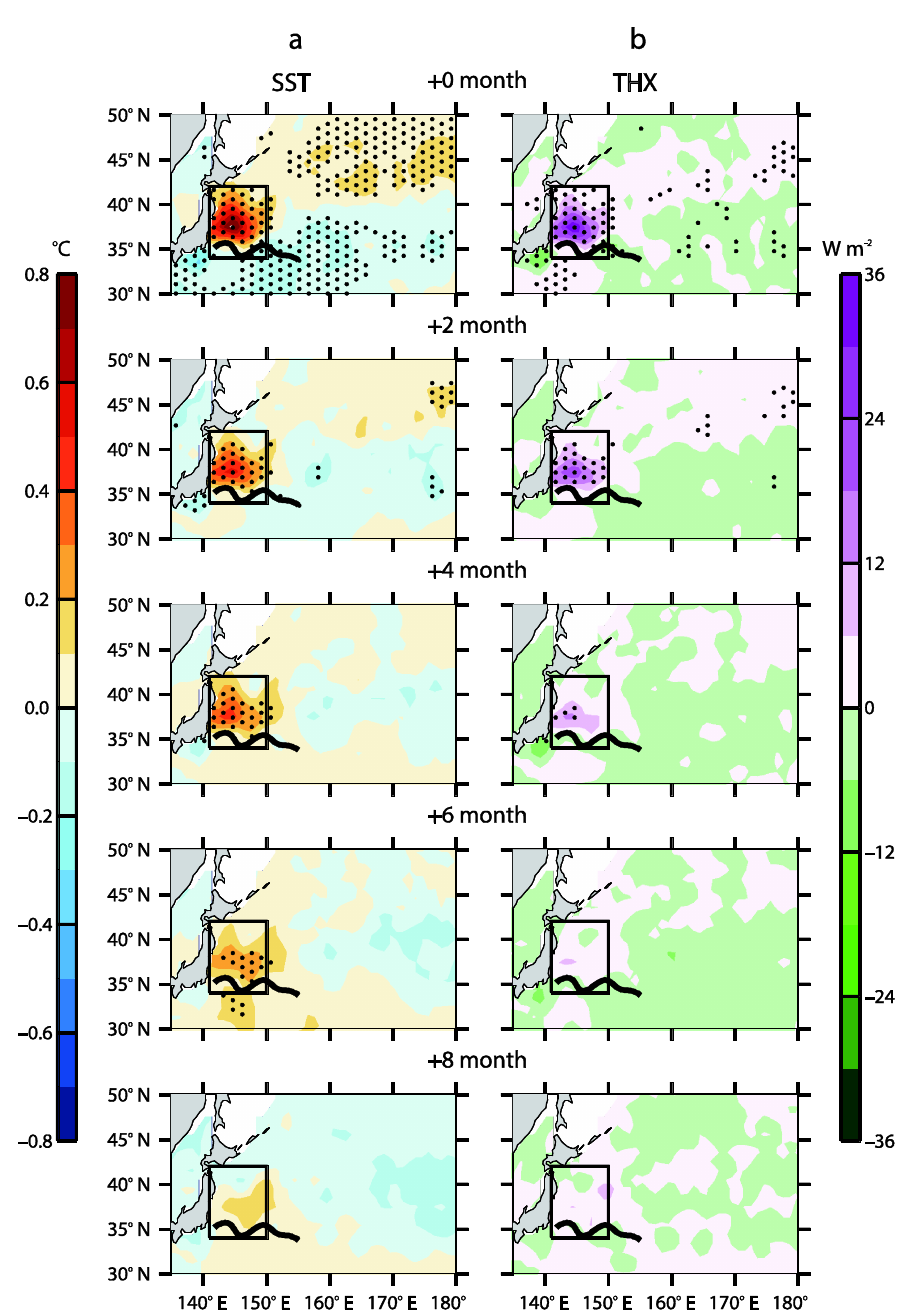
Figure 5. Regressions of the ( a ) SST and ( b ) turbulent heat-flux anomalies onto the normalized EAI when the SST and heat flux lag the EAI by 0–8 months. The black box indicates the KOCR. The thick black line represents the mean KE jet axis. The stippled areas indicate statistical significance above the 90% confidence level.